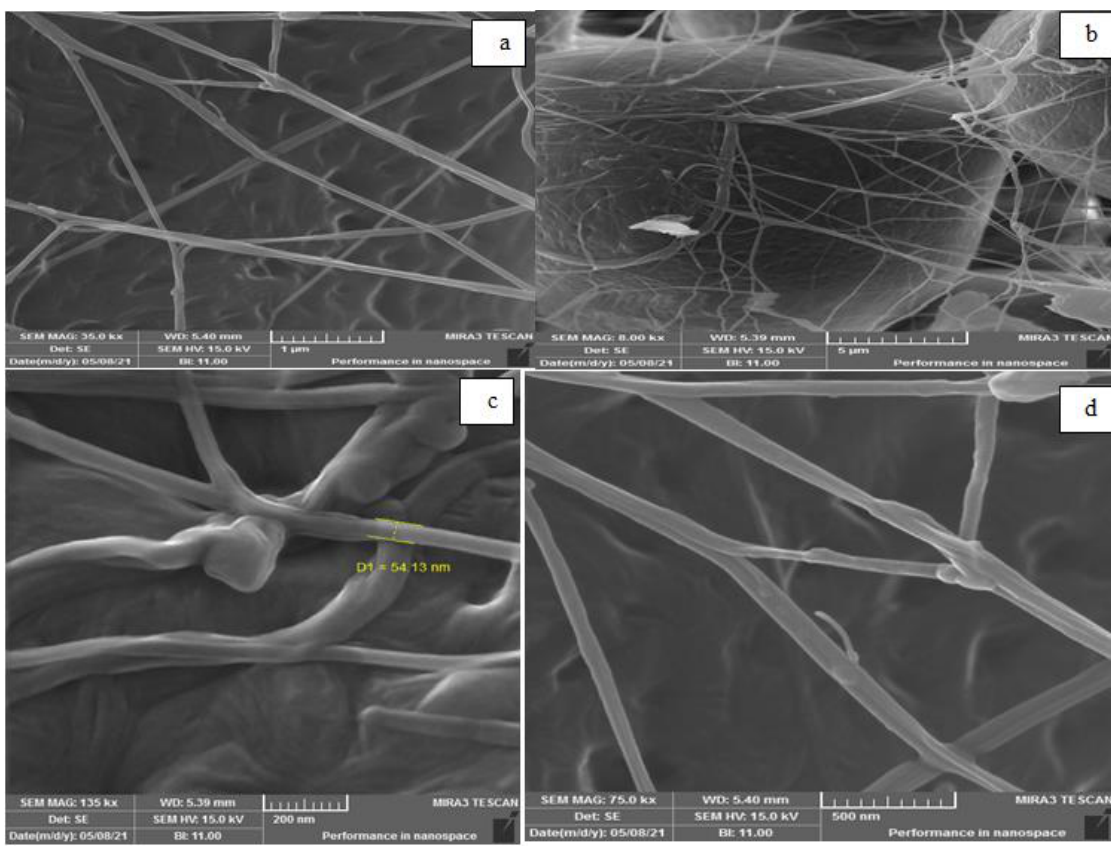
Figure 6: FESEM of PCL /HA 1/ 0.1 at different magnifications